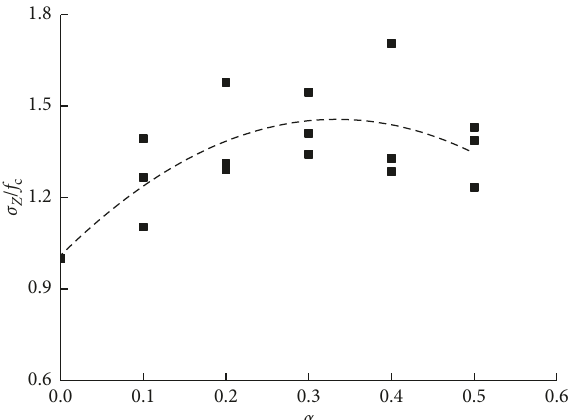
Figure 10: Biaxial compression-compression failure criterion of the two-dimensional